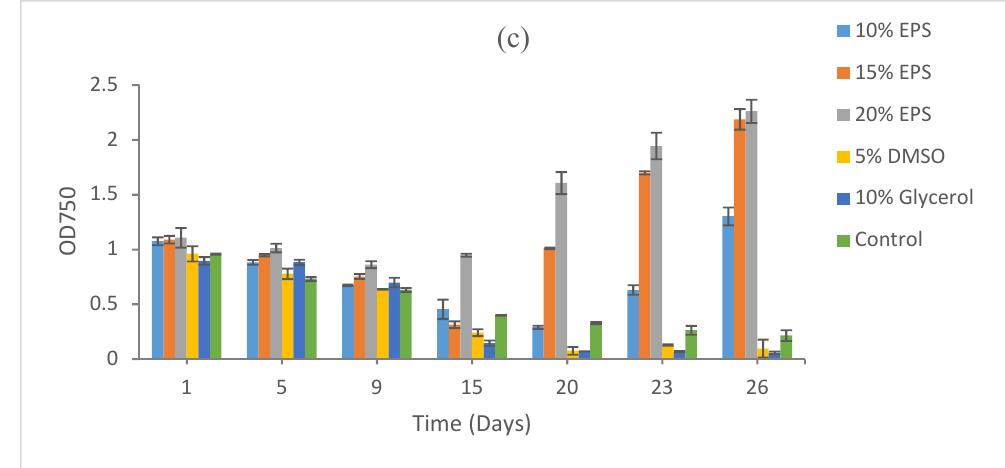
Figure 2. Growth recovery for Synechococcus sp. CB0101 after cryopreservation for ( a ) 5 days, ( b ) 15 days, and ( c ) 9 months. Duplicate samples were measured. The images of cultures at the end points refer to Figure S5.